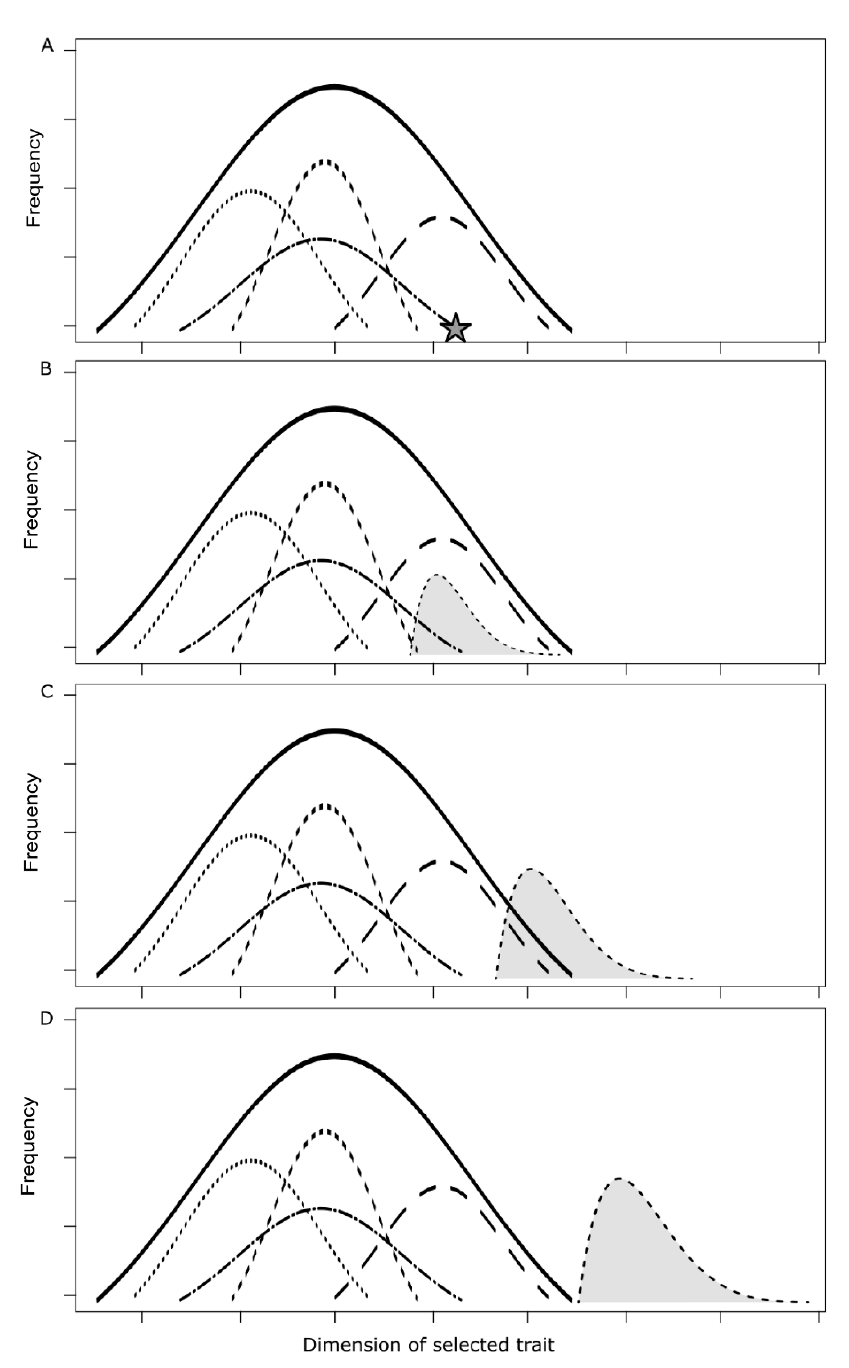
Figure 1. Hypothetical domestication continuum (frequency distributions for population means and variances of the dimension of a phenotypic trait of interest to humans, e.g., fruit size). ( A ) A species with four wild populations. A few plants are selected in one population (star) to create a new population in ( B ). ( B ) As above, with one incipiently domesticated population. Observe that the variance of the incipient domesticate is smaller than that of the wild populations, due to the selection of a small number of plants to create the new population—a result of the founder event. Observe also that the mean and variance are within the variance of the species. ( C ) As above, with one semi-domesticated population with somewhat greater variance. ( D ) As above, with one domesticated population. Observe that both the mean and the variance are outside of the variance of the species. Observe in ( B – D ) that the domesticated populations have skewed distributions, with more variation towards the right side, representing directional selection, e.g., for larger fruit. Adapted from Leakey et al. [78], with thanks to Alessandro Alves-Pereira.